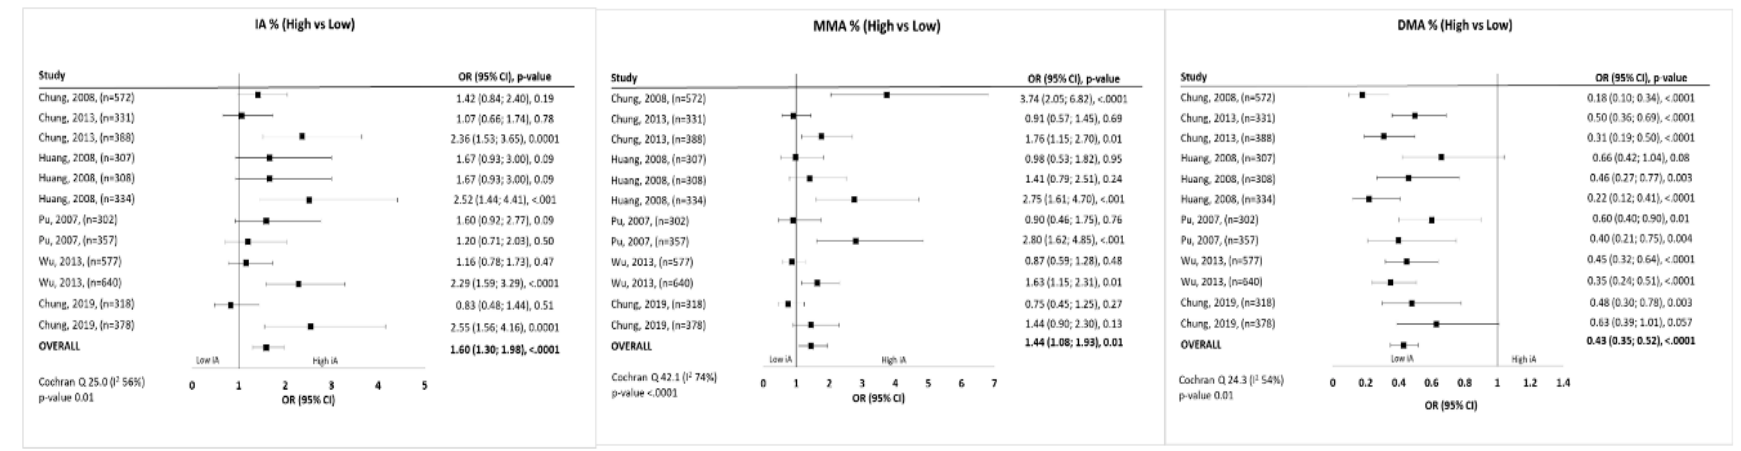
Figure 2. Forest-plot of weighted mean differences in arsenic metabolites between cases and control.